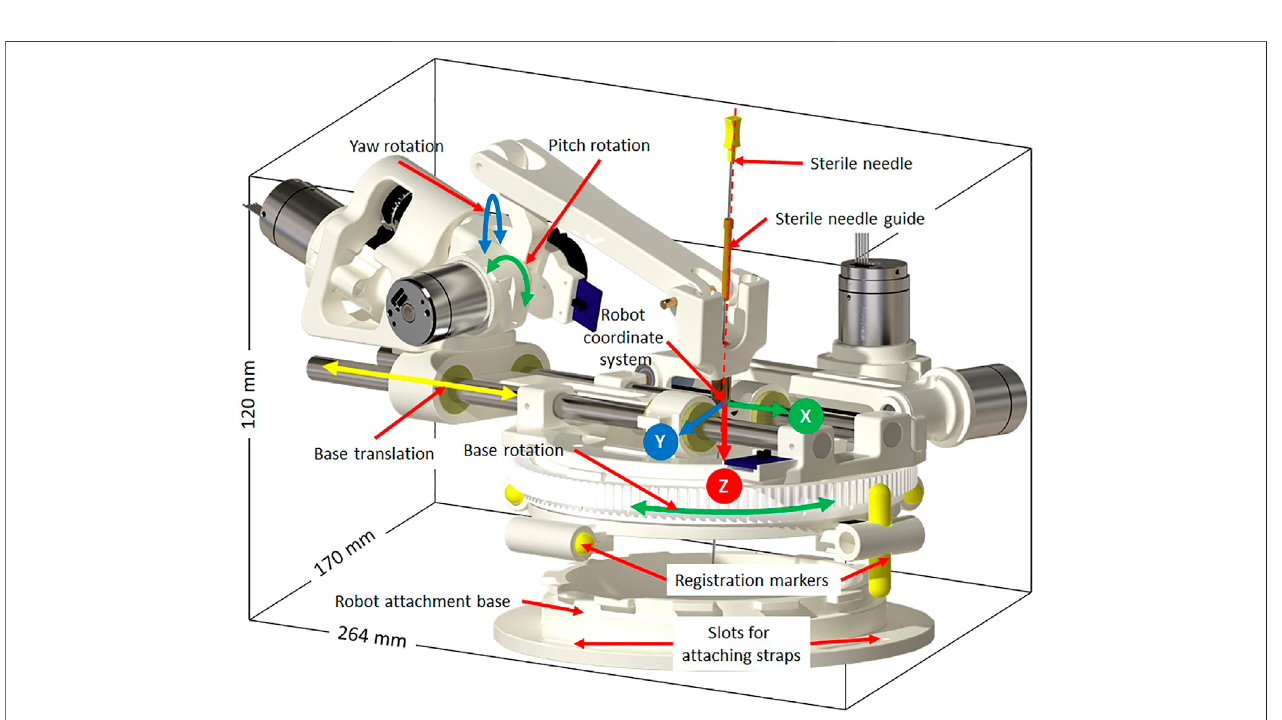
FIGURE 2 | Robot CAD model showing the degrees of freedom, robot coordinate system and sterile stylet for needle insertion.